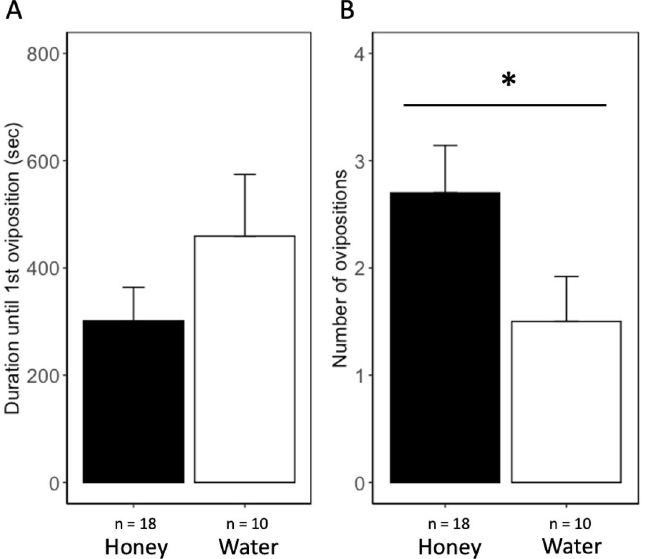
Figure 3. Duration until the first oviposition on host ( A ) and the number of ovipositions ( B ) (mean + SE) within 30 min period by H. pennsylvanicus female when provided L. zonatus host eggs and fed a honey-water (honey) or water-only diet (water). Statistical significance between treatments indicated by asterisk ( P < 0.05) (GLM and likelihood ratio chi-squared